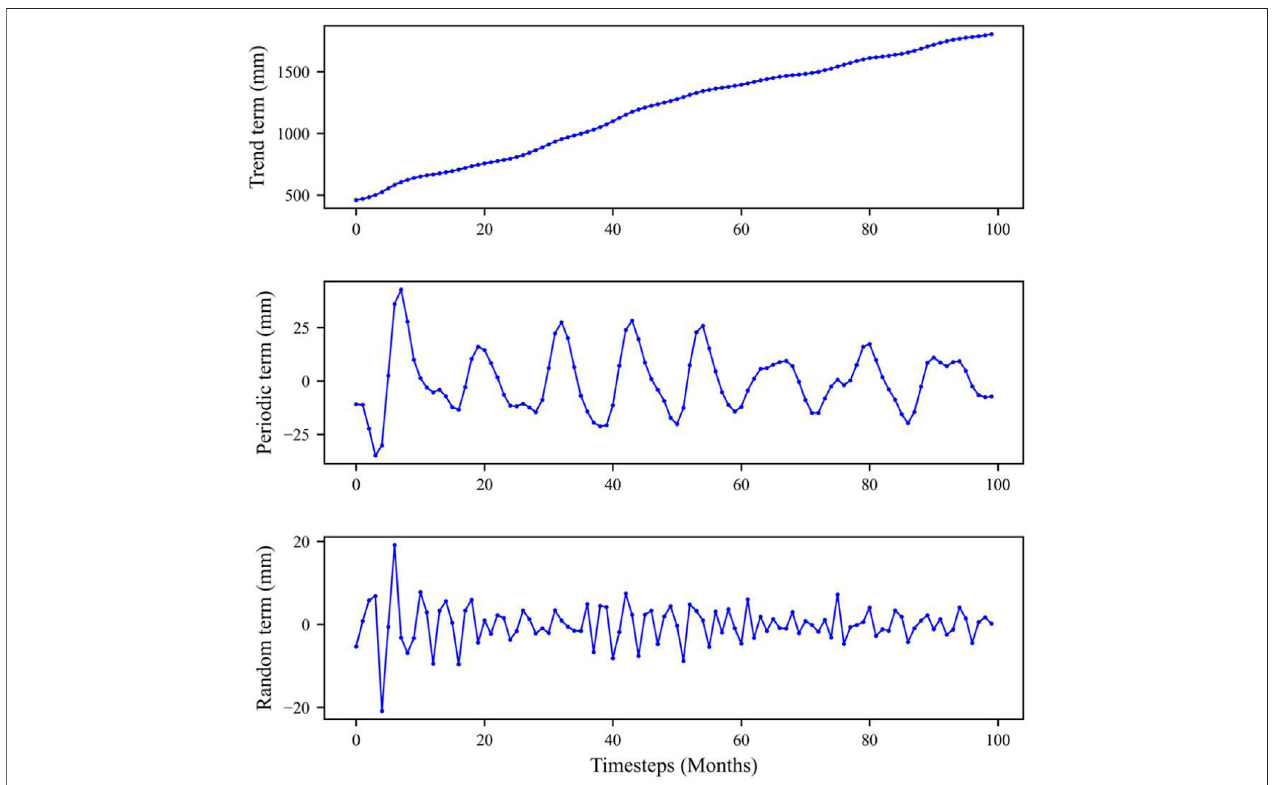
FIGURE 4 | Plot showing the decomposition of the cumulative